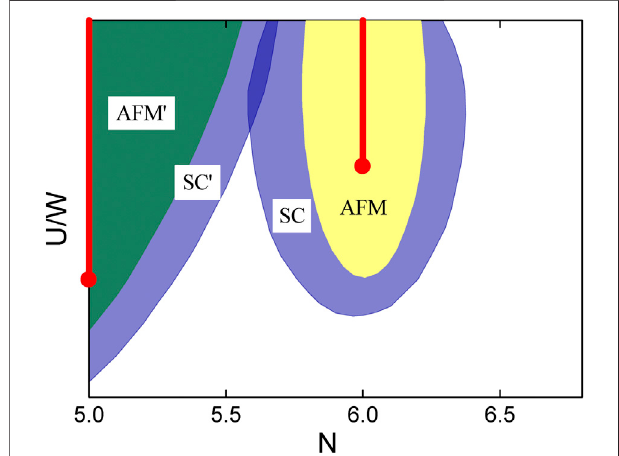
FIGURE 8 | Schematic phase diagram as a function of U / W (the ratio of the Coulomb interaction to bandwidth) and the electron fi lling $n$. Here the red lines denote the MIs at electron fi lling n (cid:2) 6 and n (cid:2) 5, respectively. AFM marksthe ( π , 0 ) AFMorder nearthe n (cid:2) 6MI, whileAFM ′ representsthe AFM order near the n → 5 limit [64]. SC and SC ′ denote two superconducting states near the two AFM phases, adapted from